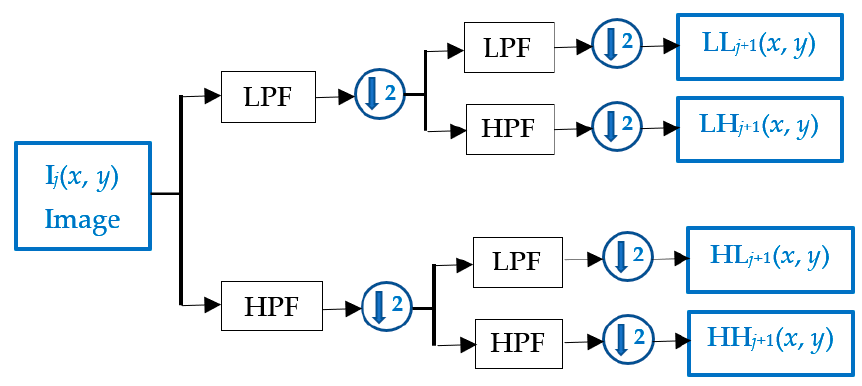
Figure 1. DWT of an image I from level j to j + 1 producing sub-bands LL j +1 , LH j +1 , HL j +1 , and HH j +1.